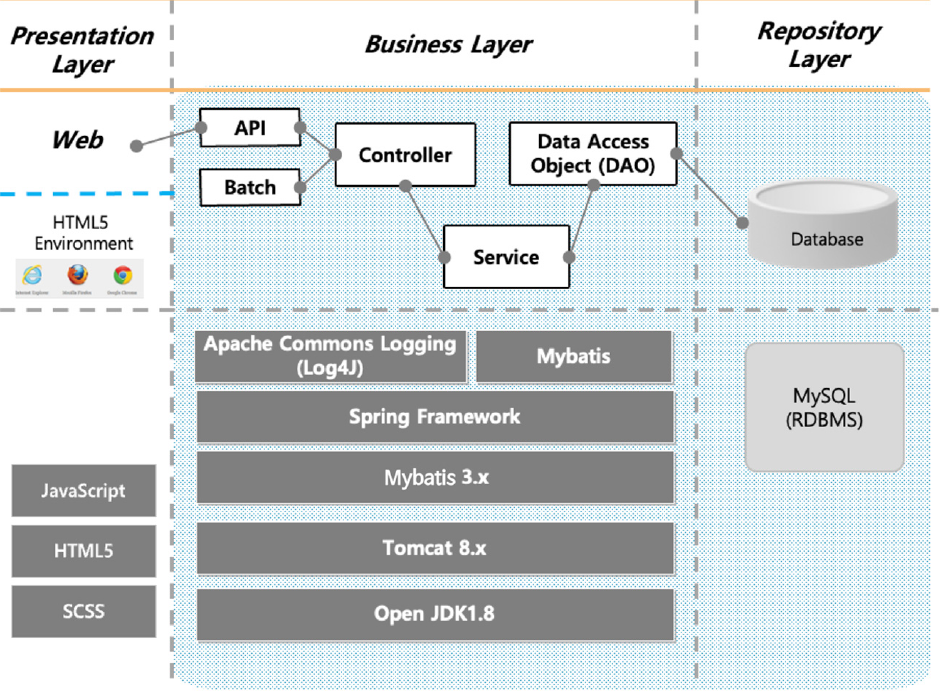
Figure 3. Technical specifications.